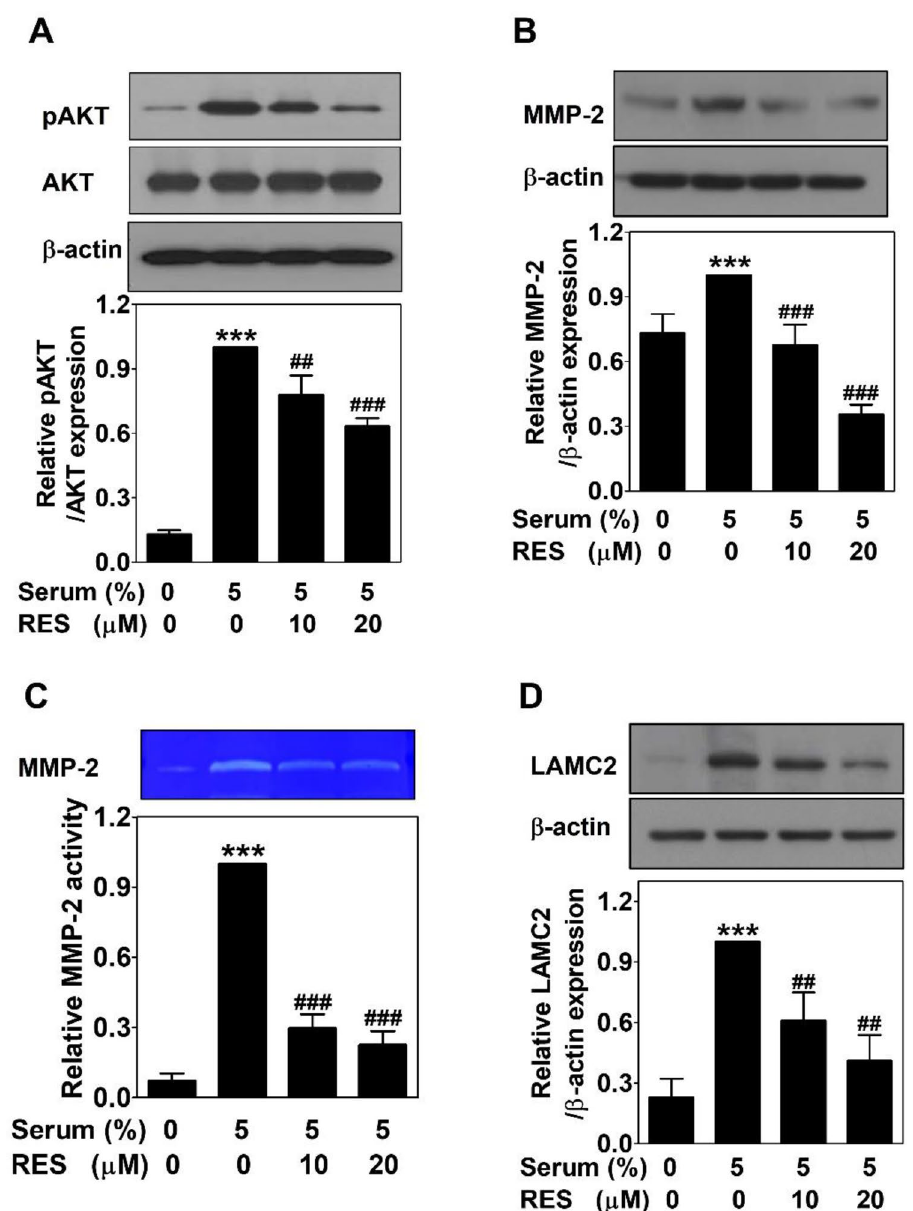
Figure 6. Resveratrol inactivates serum-induced the AKT signaling pathway in PC-3 cells. Cells were treated with serum with or without RES for 24 h. The same amount of proteins (25–30 μg) were analyzed by Western blot using the phospho-AKT, AKT ( A ), MMP-2 ( B ) and LAMC2 ( D ) antibodies. As a loading control, β-actin was used. ( C ) Gelatin zymography was performed using the CM. Data present as the means ± SD of three independent experiments by analysis of Student’s t- test. *** p < 0.001 versus untreated control; ## p < 0.01 and ### p < 0.001 versus serum-treated